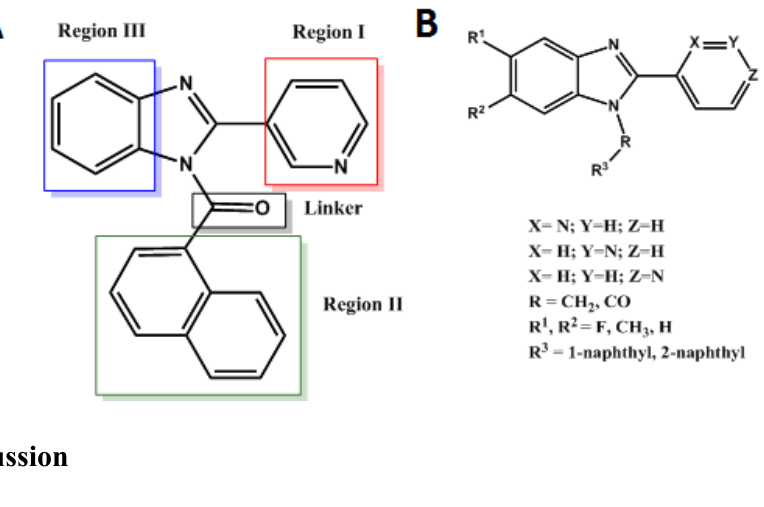
Figure 2. A. Regions for modification on compound 14 . B. General structure of synthesized